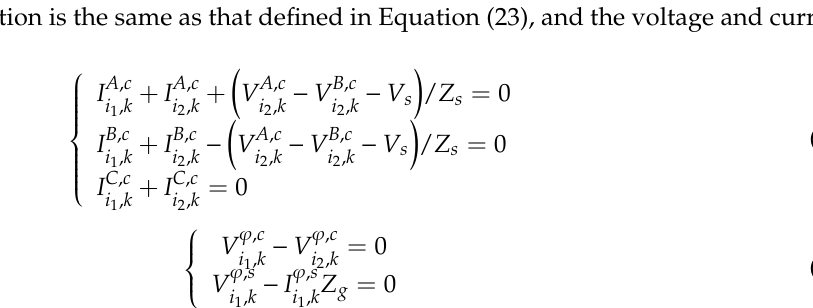
Figure 4. Structure of the typical interconnected node with the power-line communication (PLC) transmitter (Tx).